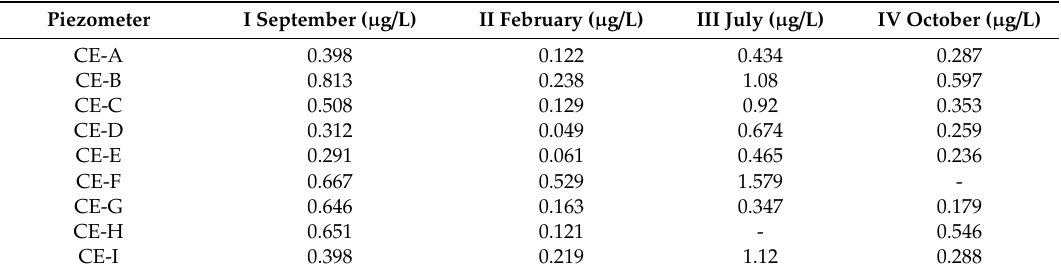
Table 5. Sum value of all organic contaminants ( µ g / L) found in each piezometer (CE-A, CE-B, CE-C, CE-D, CE-E, CE-F, CE-G, CE-H, and CE-I) and at each